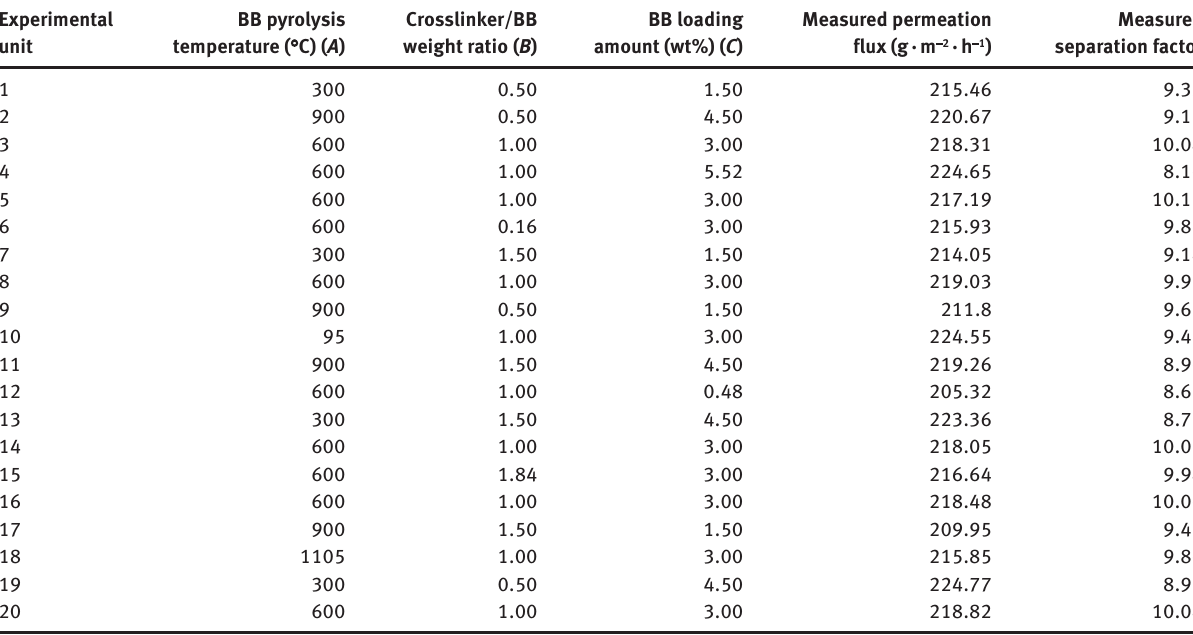
Table 2: Experimental design units and measured results for the response variables.